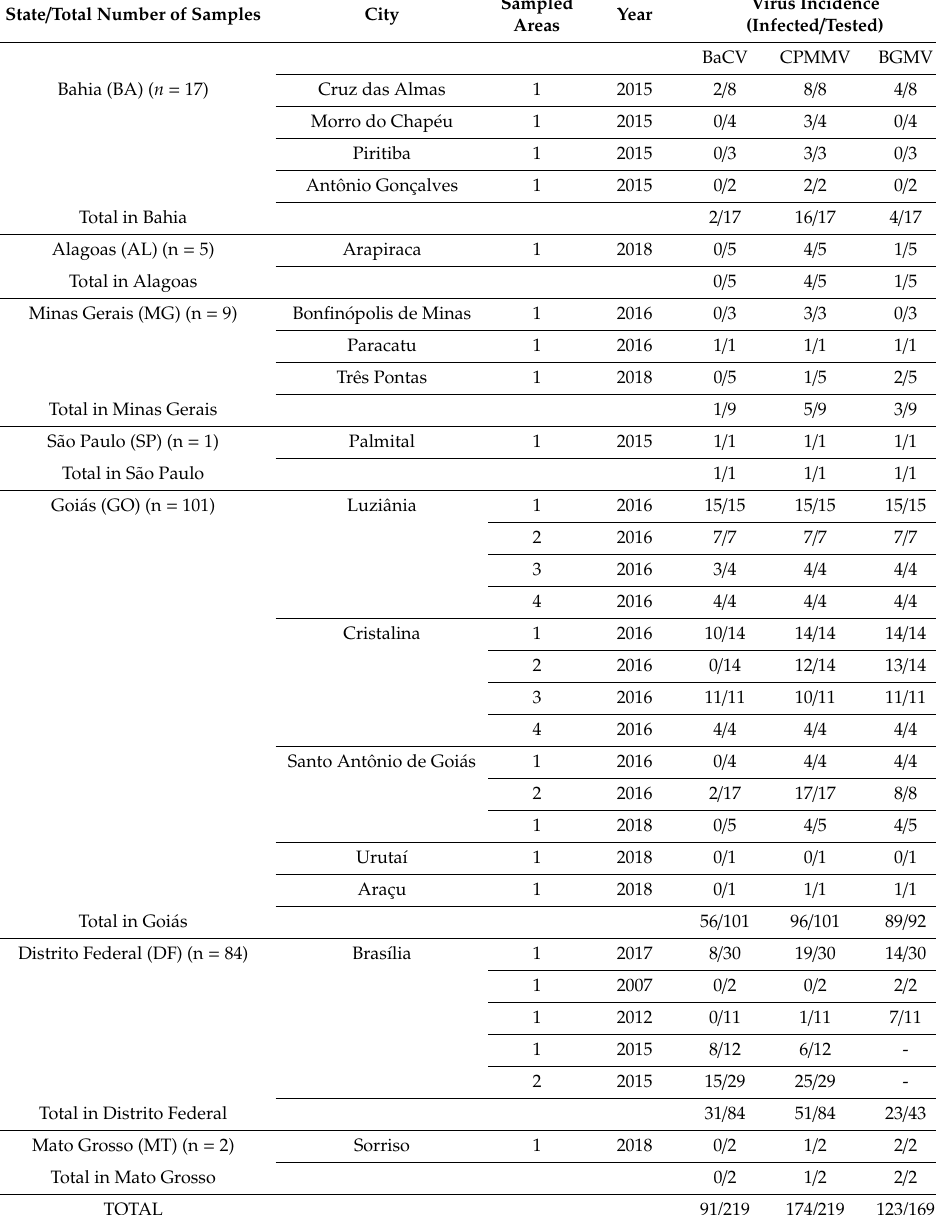
Table 1. Detection of BaCV, CPMMV, and BGMV in common bean samples collected in Brazil by RT-PCR and